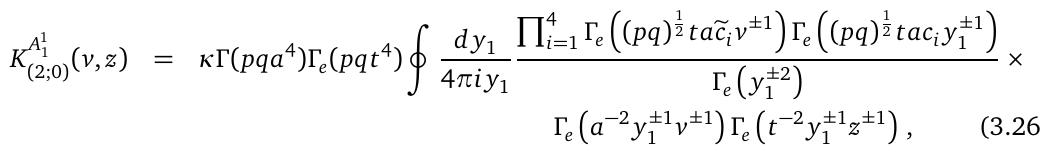
and SU ( 2 ) minimal z v